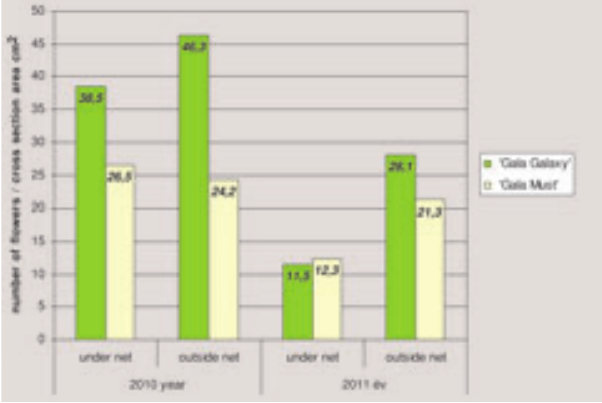
Figure 2. Specific number of flowers under and outside of the hail nets ( Debrecen – Pallag, 2010–2011)